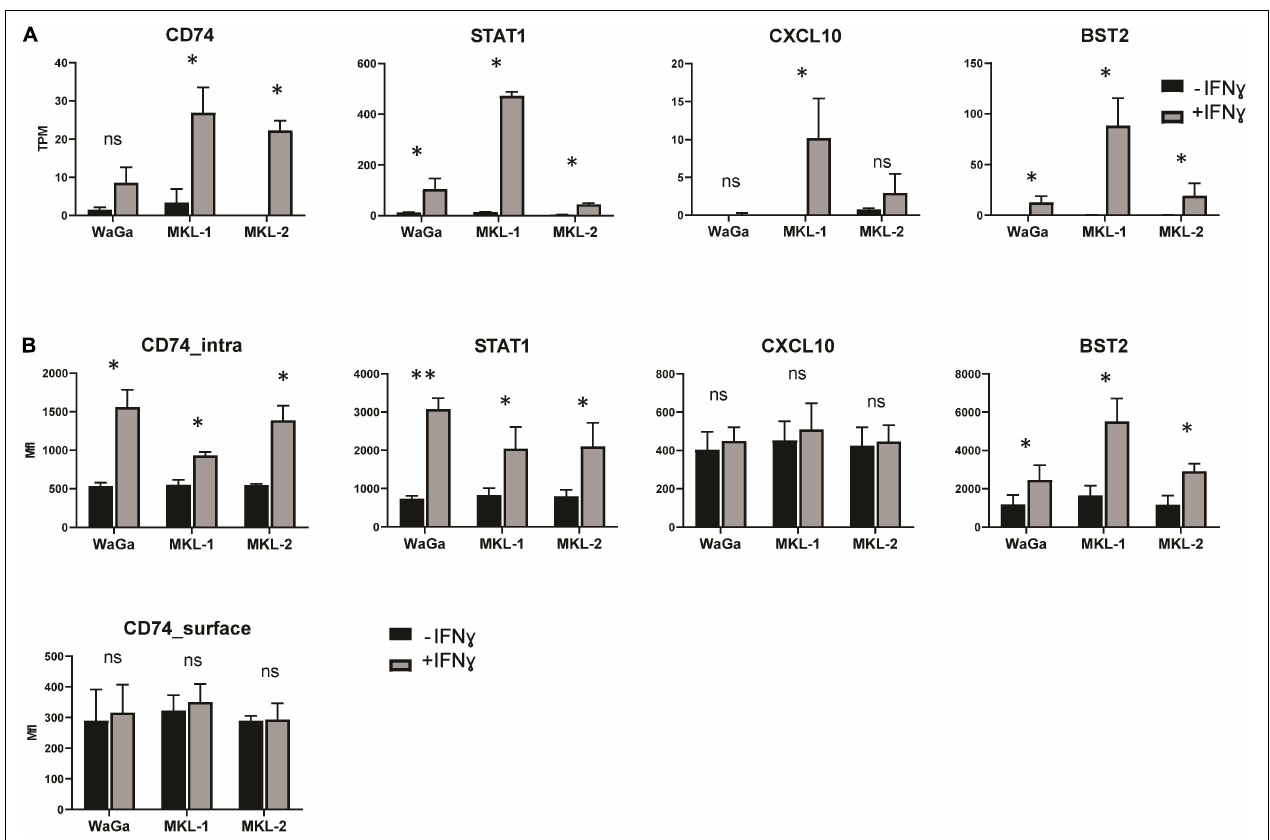
FIGURE 6 | Validation of differential gene expression in MCC cell lines on protein level and mRNA level. (A) TPM values were acquired from our sequencing output. The data represent mean values ± SEM from three independent experiments (two for MKL-1 control). (B) After 72 h of treatment with or without IFN γ (3,000 U/ml), the Merkel cell carcinoma cell lines MKL-1, MKL-2, and WaGa were stained for signal transducer and activator of transcription 1-alpha/beta (STAT1), bone marrow stromal antigen 2 (BST2), C-X-C motif chemokine 10 (CXCL10), and HLA class II histocompatibility antigen gamma chain (CD74) and analyzed by flow cytometry. The average MFI of three independent experiments ± standard error is indicated. p -values were determined using the paired student’s t -test. ∗ p < 0.05; ∗∗ p < 0.01; ns, not